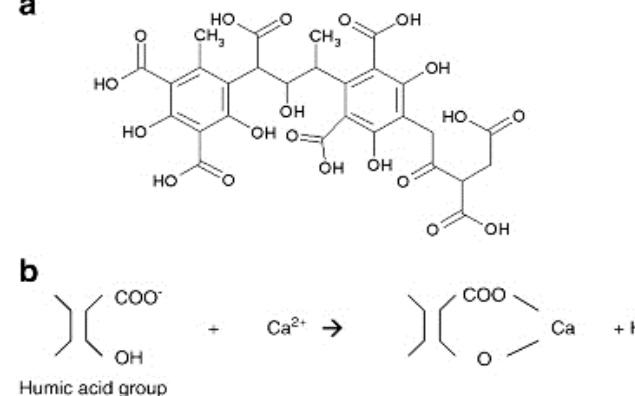
Figure 3. Structure of Humic acid ( a ) Binding of calcium with the humic acid group ( b ) adapted from Reference